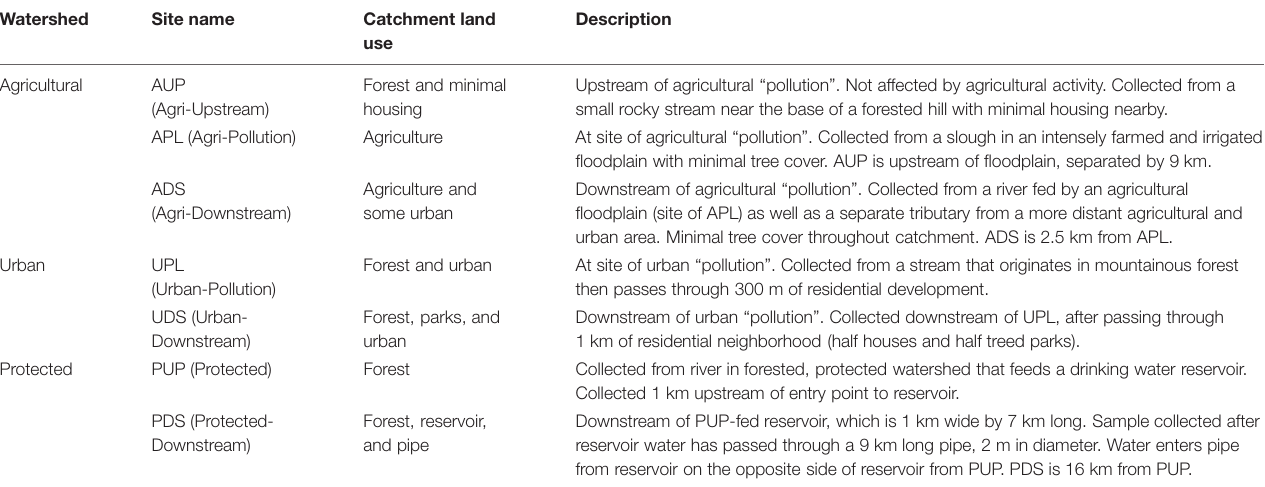
TABLE 1 | Description of sampling sites across watersheds with varying land use.